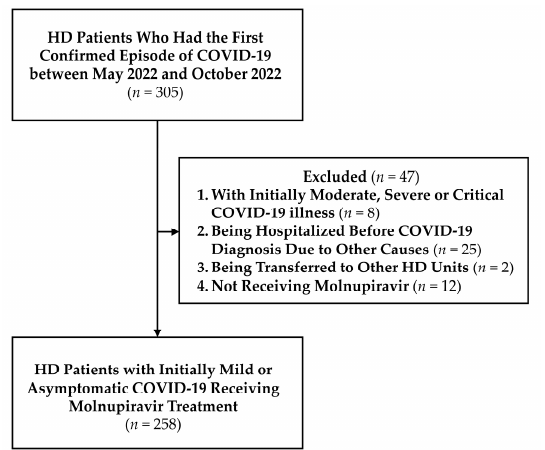
Figure 1. Enrollment of the Study Cohort. COVID-19, coronavirus disease 2019; HD, hemodialysis; n ,